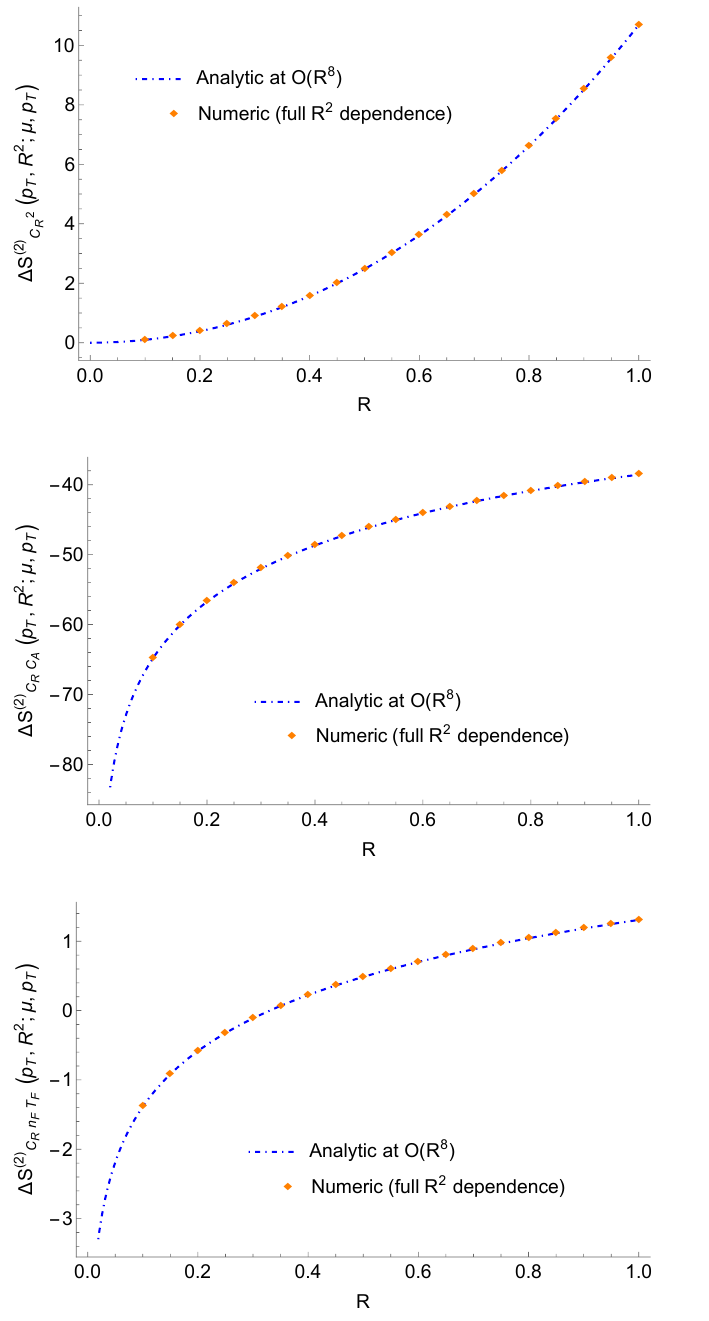
Figure 1 . Comparison between the numerical calculation with full R 2 dependence (orange diamonds) and the analytic expansion through O ( R 8 ) (blue dot-dashed lines) for the three colour structures contributing to the two-loop soft